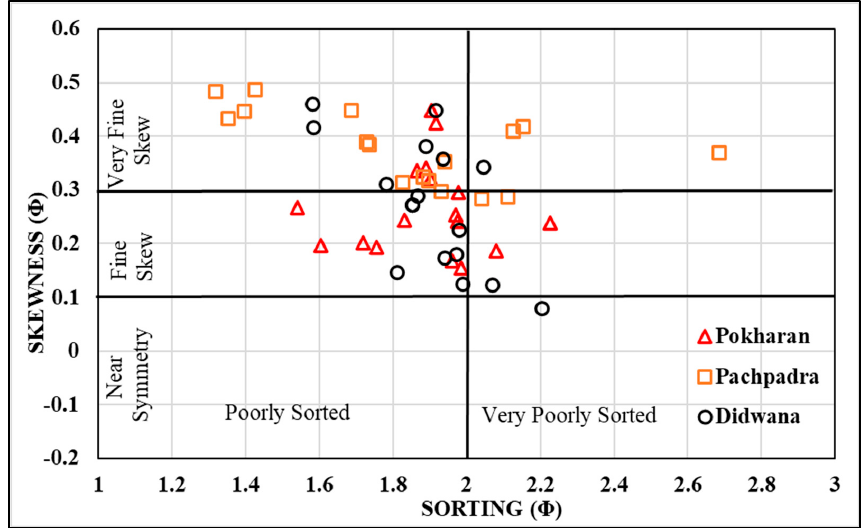
Figure 4. Bivariate plot between sorting and skewness.